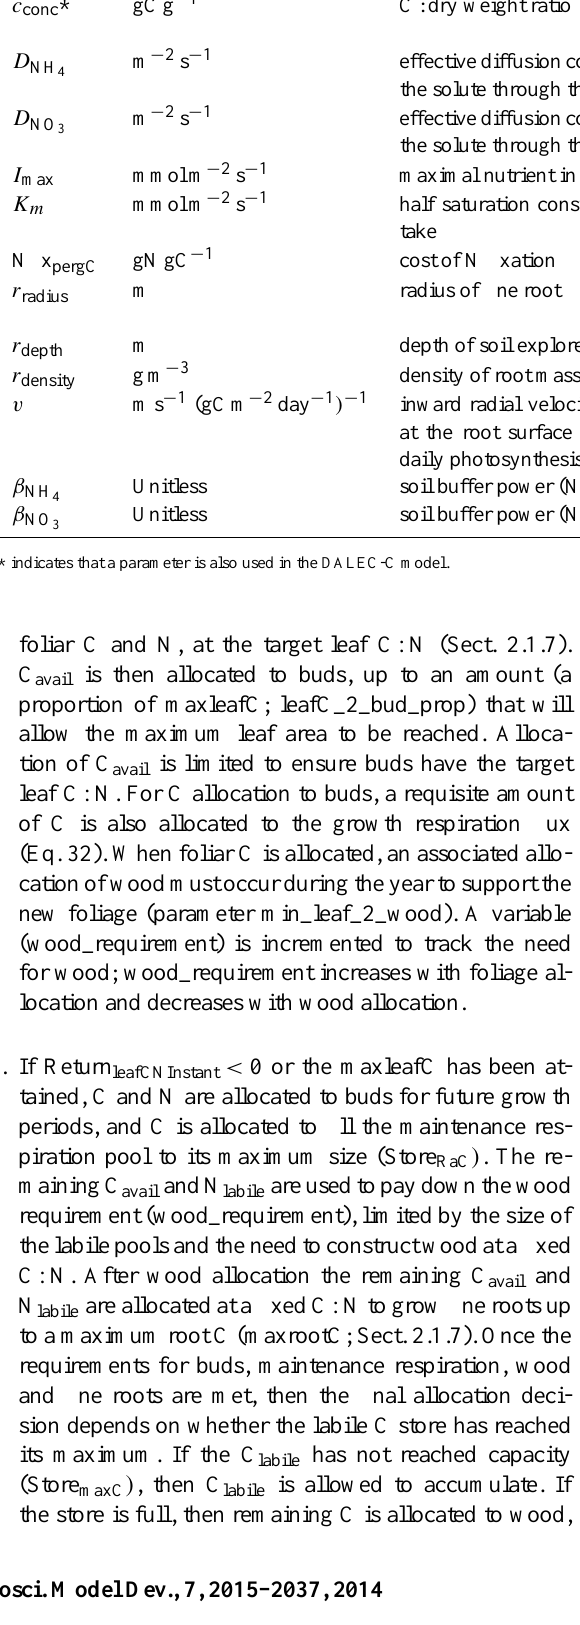
effective diffusion coefficient